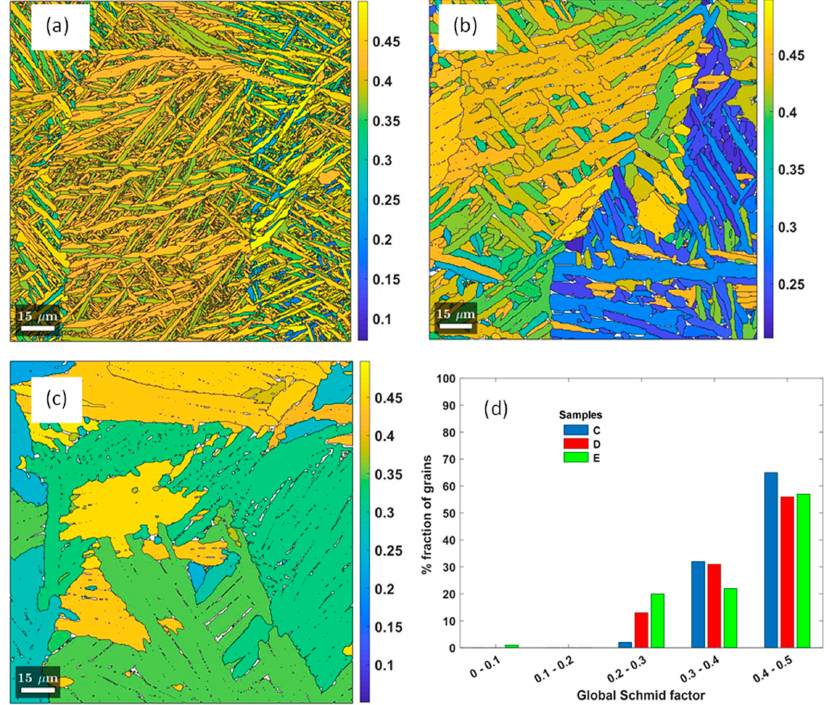
Figure 10. Typical values of the global Schmid factor for pyramidal < α > slip systems of the α -phase for the load applied along the build orientation in samples ( a ) C, ( b ) D and ( c ) E, while ( d ) shows the statistical distribution of the values obtained in each form of